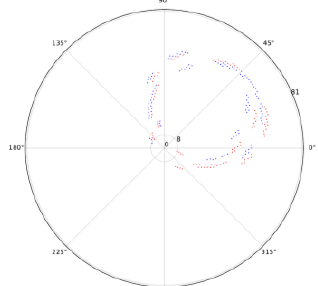
Fig. 3. An event display of the multi-turn track in the MDC in polar coordinates. Dots are the wire position at the endcap with hit. Red dots are the hits from the first turn and blue dots are the hits from the non-first